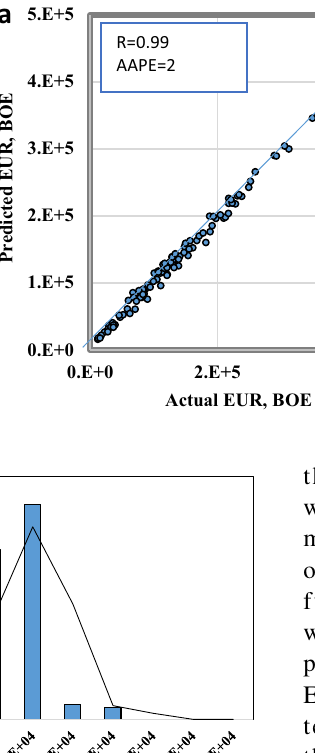
Fig. 10 The actual versus calculated EUR plot for the LR model in the case of a the train- ing and b the testing data sets